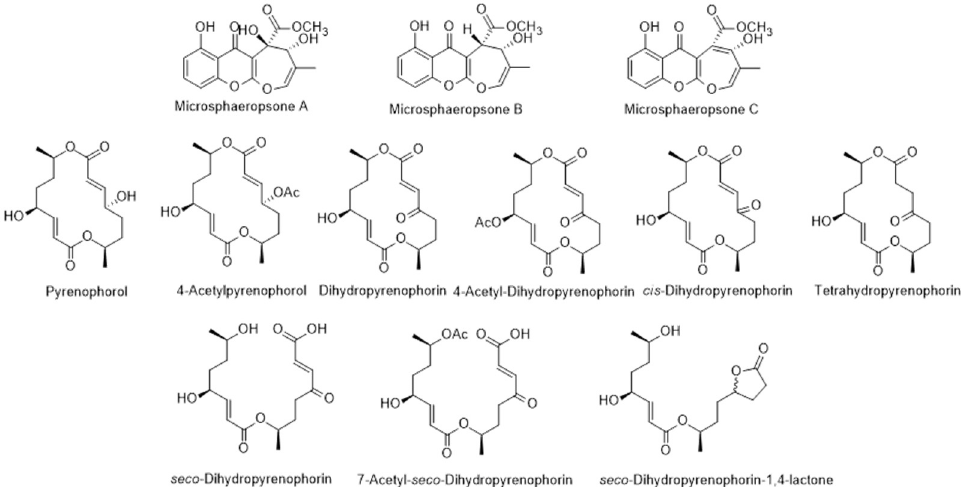
Figure 9. Metabolites isolated from endophytic Microsphaeropsis sp. (the first three compounds) and Phoma sp. isolated from L. intricatum .